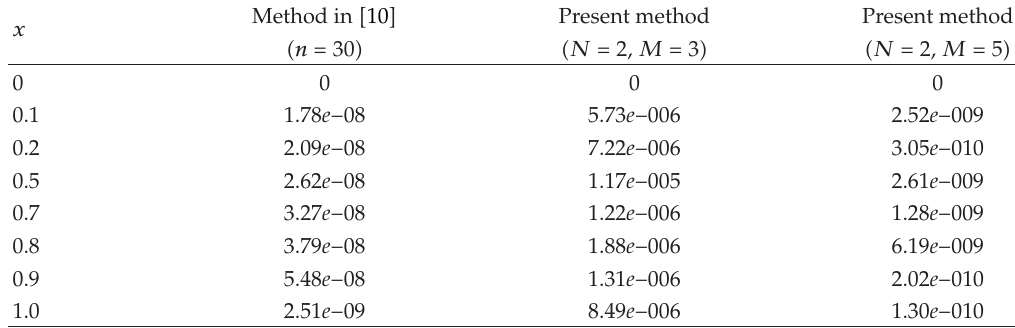
Table 1: Comparison of the absolute errors for Example 5.2.